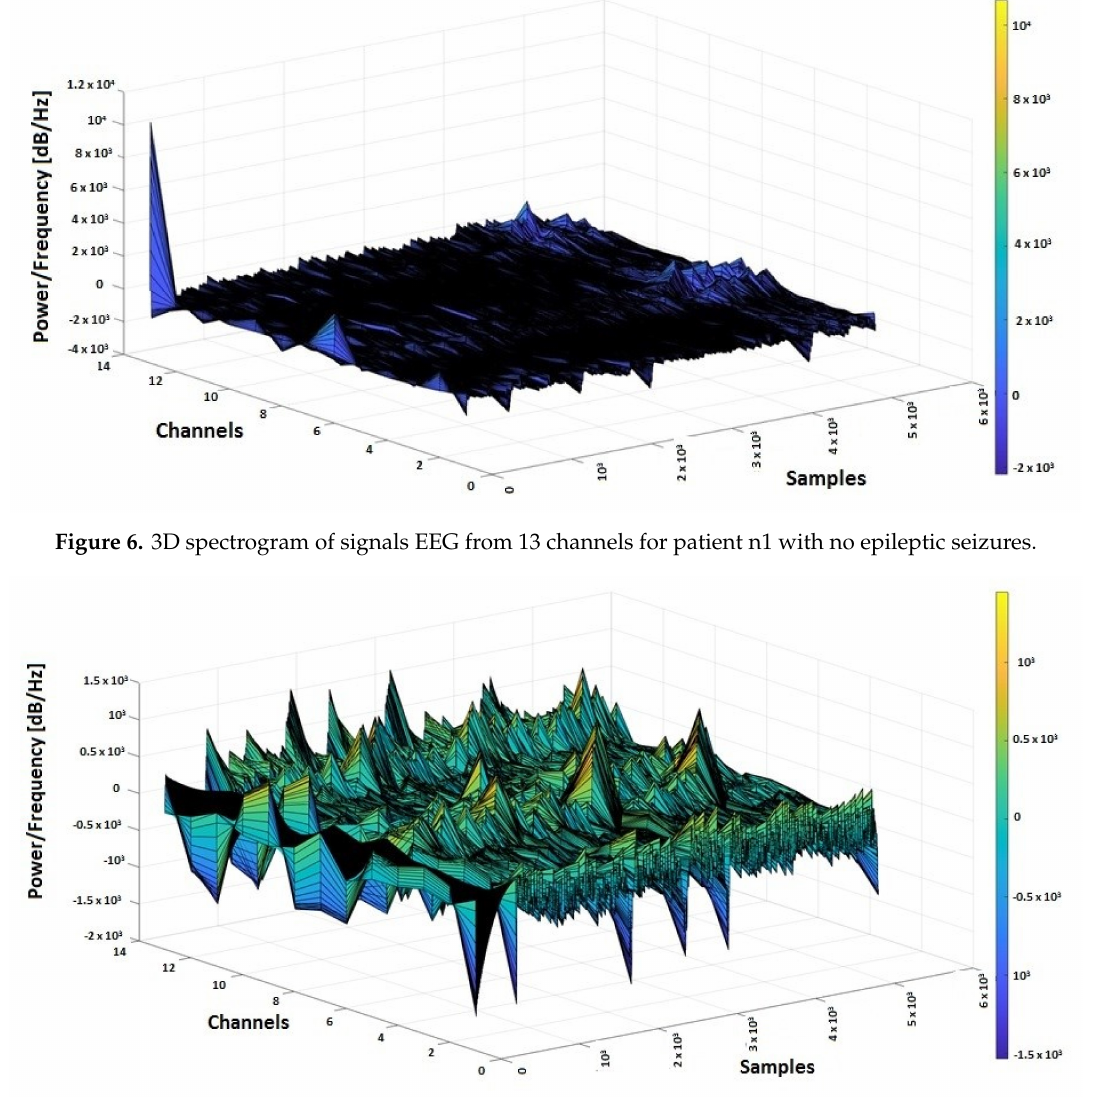
Figure 7. 3D spectrogram signals EEG from 13 channels for patient n2 with epileptic